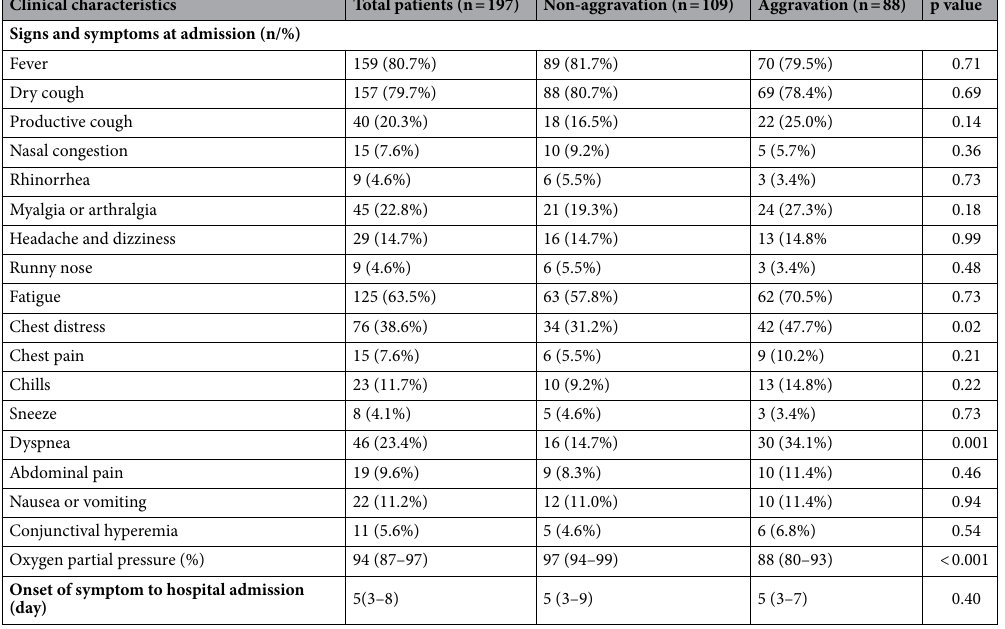
Table 2. Signs and symptoms of the two groups. Data are median (IQR), n